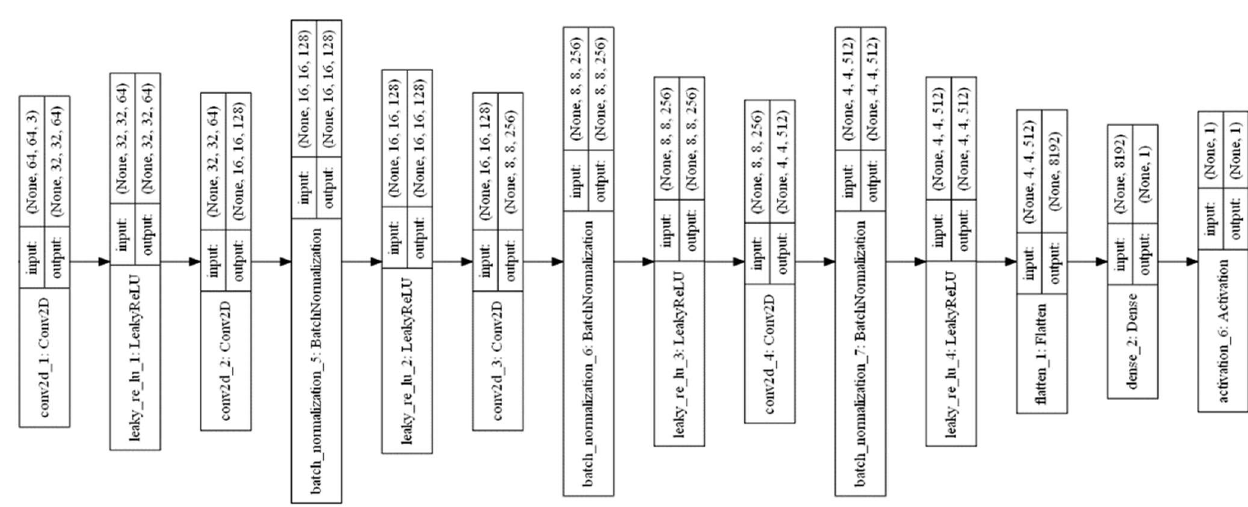
Figure 5. Layered structure of DCGAN discriminator.